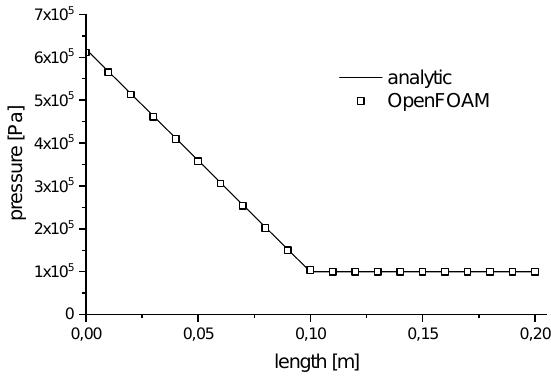
Figure 4. Pressure distribution in x-direction in the plate at the end of the injection step with a filling up to 0.1 m.